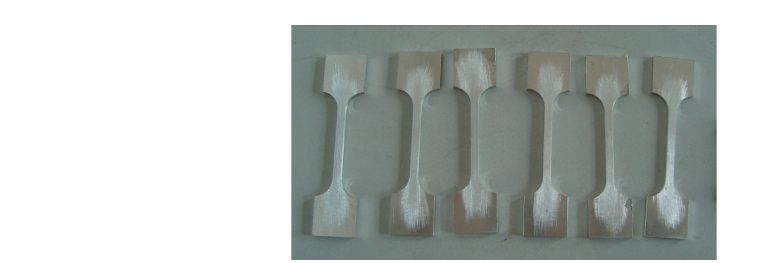
Figure 22: Performance of test specimens. Table 7: Measurement and performance data of cylindrical magnesium alloy shell